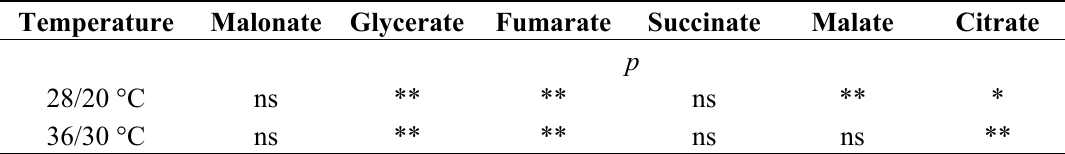
Table 2. ANOVA results for CO 2 enrichment effects on organic acids in soybean leaflets. Data were collected on days 0 to 4 using leaflets from plants in continuous temperature treatments and following reciprocal shifts among growth temperature